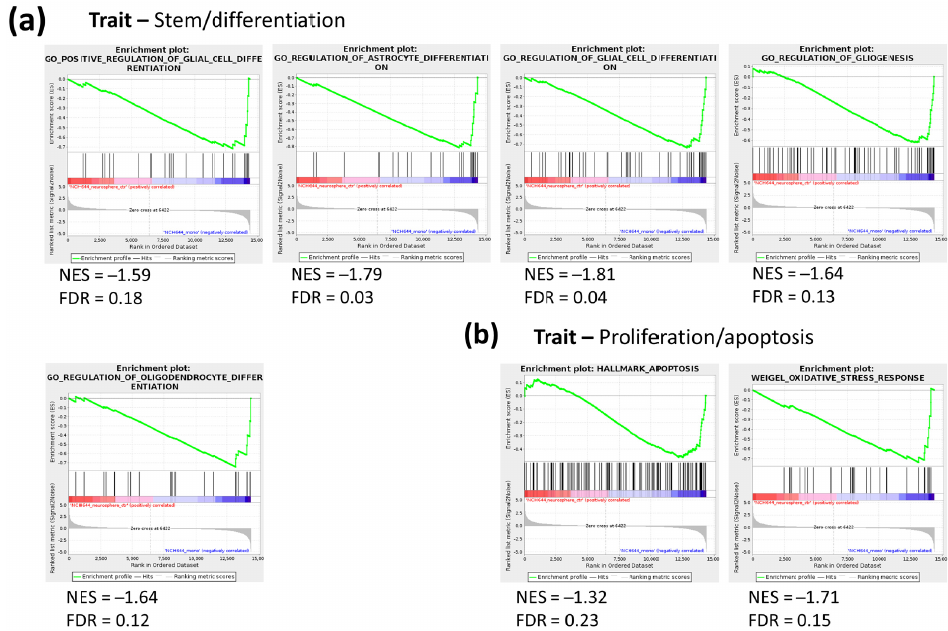
Figure 3. GSEA of gene sets associated with stem/differentiation and proliferation/apoptosis traits in NS vs. ML from NCH644 cells. ( a ) Several differentiation-associated gene sets are enriched in NS. ( b ) Gene sets associated with apoptosis and oxidative stress response are downregulated in NS; n = 3, FDR <